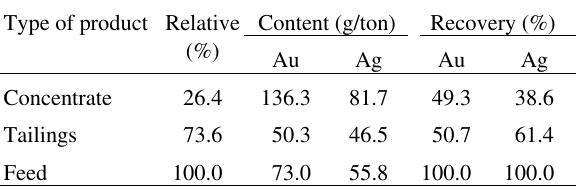
Table 3. Results of product froth flotation